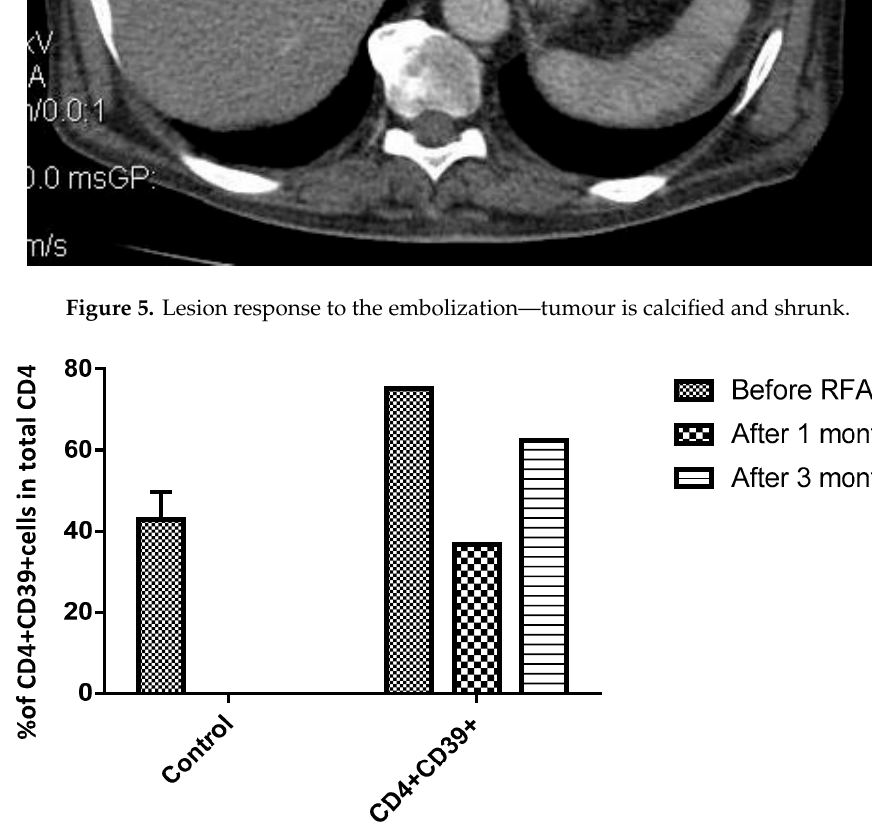
Figure 6. The frequency of CD39 + CD4 + T cells in the peripheral blood. The percentage of CD39 + CD4 + cells in total CD4 + T cells was decreased after 1 month and increased after 3 months, but did not reach the index before the RFA procedure.